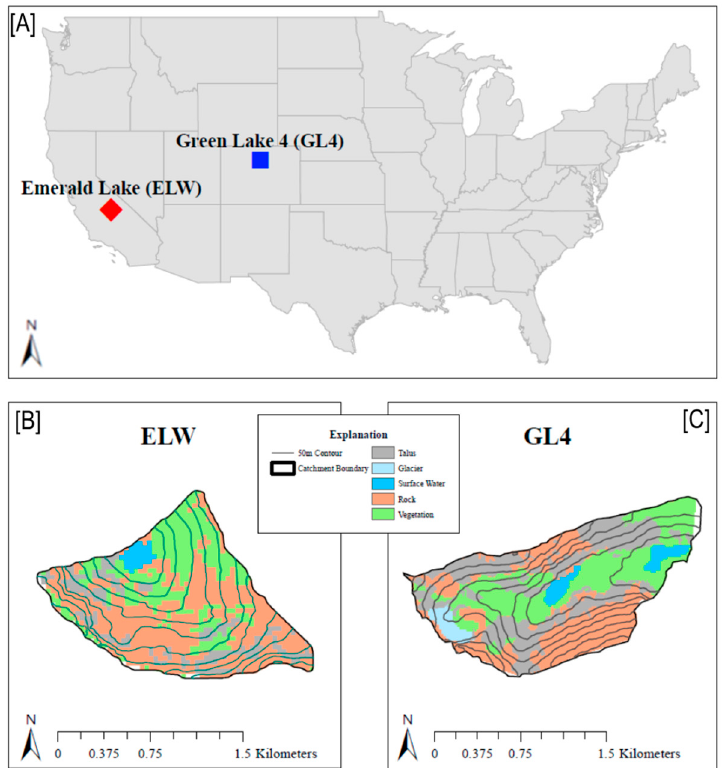
Figure 6. General location in the Conterminous United States ( A ) and land coverage of the two study catchments: Emerald Lake Watershed (ELW), a 1.2 km 2 catchment in the Sierra Nevada of California ( B ) and Green Lake 4 (GL4), a 2.25 km 2 catchment in the Rocky Mountains of Colorado ( C ).